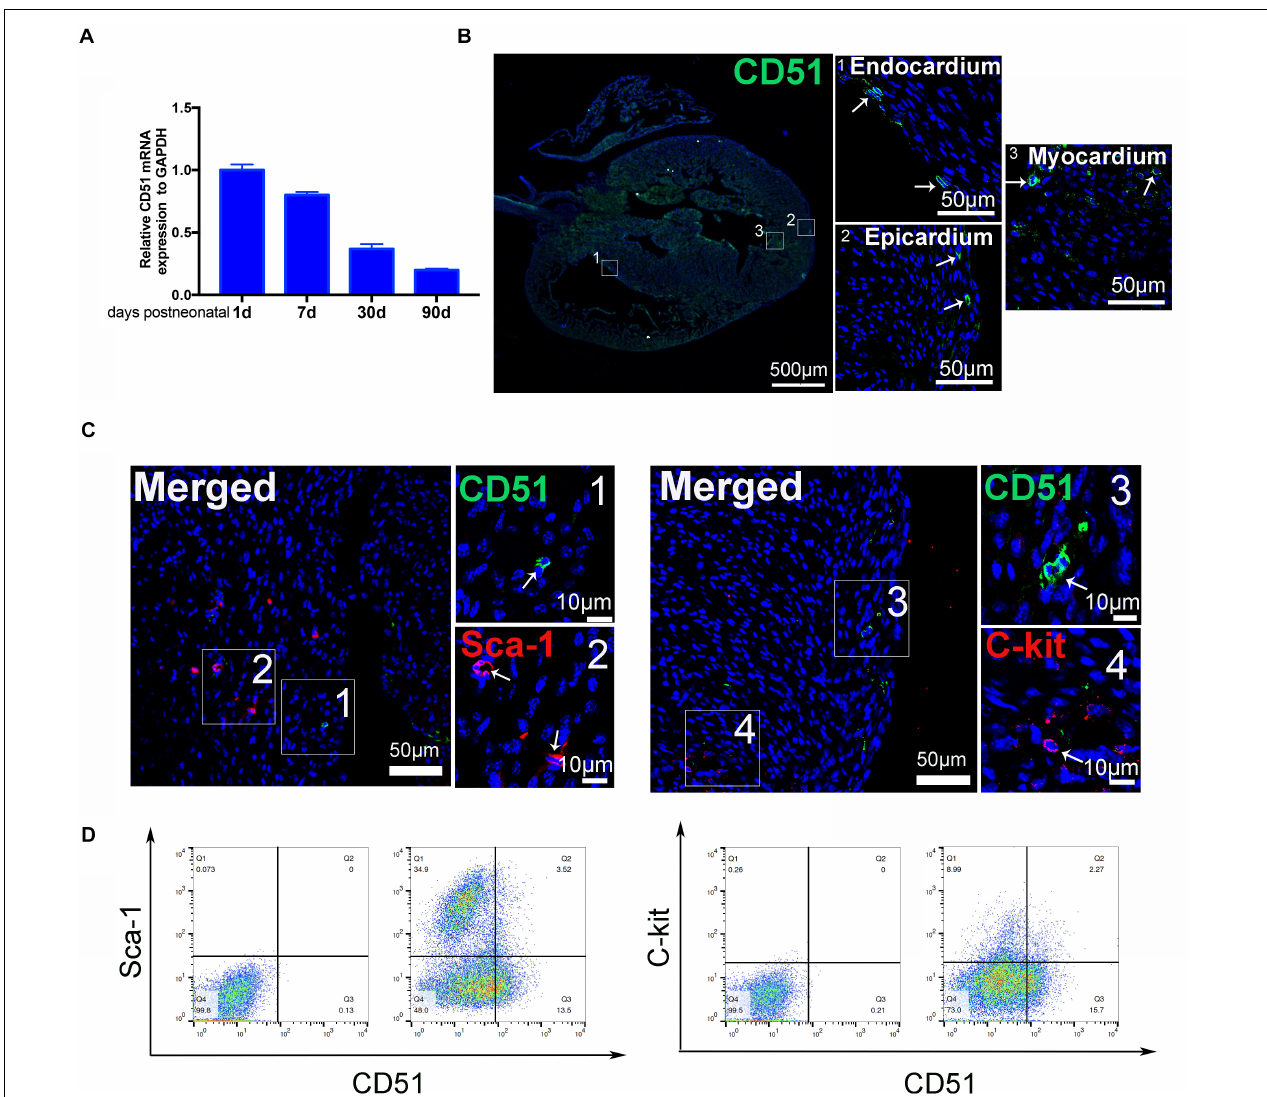
FIGURE 1 | Characteristics of cardiac CD51 in mice. (A) mRNA expression of cardiac CD51 in mice of different ages was assessed by quantitative PCR, CD51 expression was decreasing with age, and data were normalized to GAPDH; values were presented as the mean ± SEM, n = 3. (B , C) Hearts from 7-day-old mice were stained with CD51 (green), Sca-1 (red), and C-kit (red); CD51-positive cells were located in all layers of the heart wall, including the endocardium, epicardium, and myocardium; few CD51-positive cells were co-localized with Sca-1- or C-kit-positive cells, nuclei were counterstained with DAPI (blue), and scale bars were marked in the figure. (D) Flow cytometry assessment of cardiac CD51-positive subpopulation with Sca-1- or C-kit-positive subpopulation in 7-day-old mice, and only a few cells simultaneous expressed two